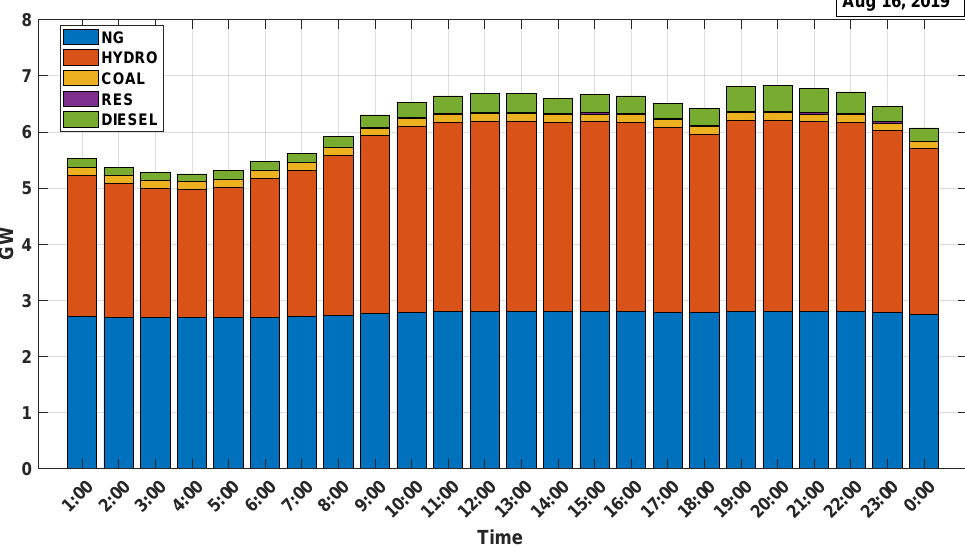
Figure 11. Contribution added to the dispatch by type of technology—stage